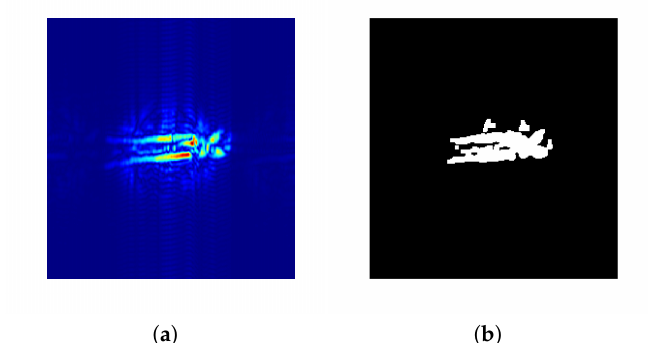
Figure 32. Pliers: ( a ) Scan; ( b ) Segmented image.